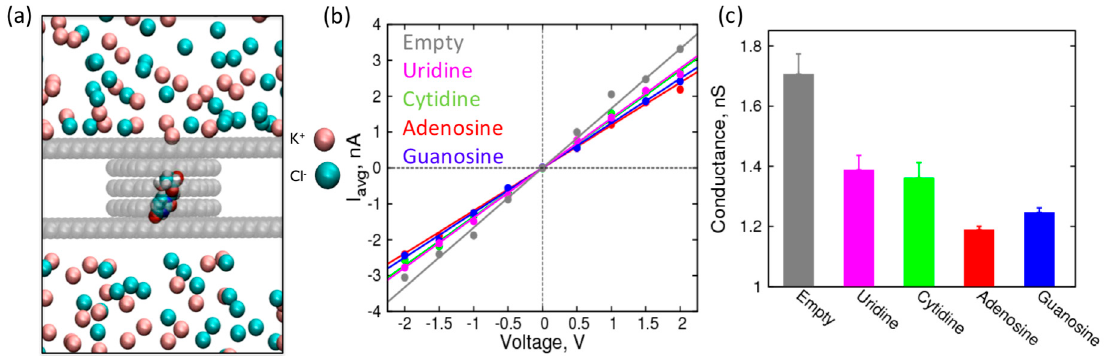
Figure 4. Characterization of a 1.5 nm graphene nanopore in the presence of canonical nucleosides: ( a ) Simulation snapshot of the system showing nucleoside localization to a nanopore. Van der Waals representation is used for the graphene carbon atoms, nucleoside, and ions. Water molecules are excluded for clarity; ( b ) I-V curves with their corresponding straight line fits for empty 1.5 nm pore (grey), pore with canonical uridine (magenta), cytidine (green), adenosine (red), and guanosine (blue) localized at the center of the nanopore in 1 M KCl; ( c ) Resistance (M Ω ) of 1.5 nm pore with canonical